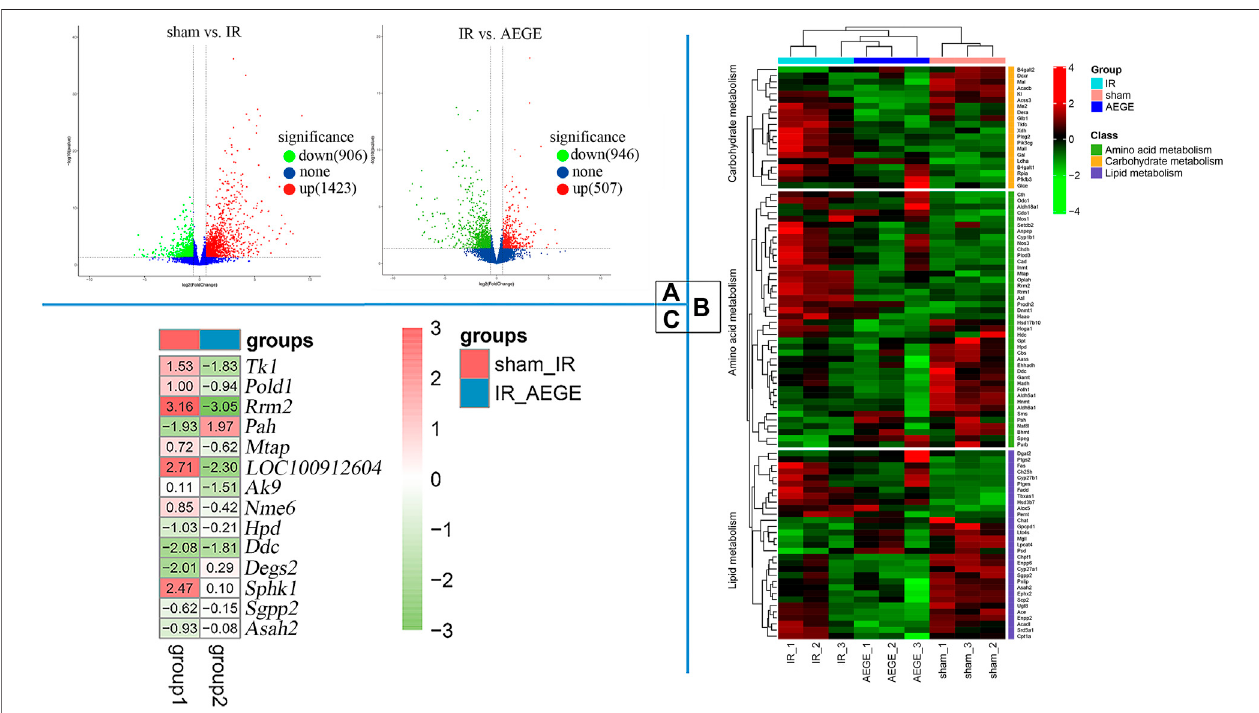
FIGURE4| TranscriptomicsforCIRinjuryinducedbymiddlecerebralarteryocclusion. (A) Volcanoplotsdrawnforallidenti fi edgenes. (B) ClusteranalysisofDEGs and heatmap according to DEGs type of pathways. Red for higher level and green for lower level. (C) Heatmap of restored genes after treatment with AEGE.